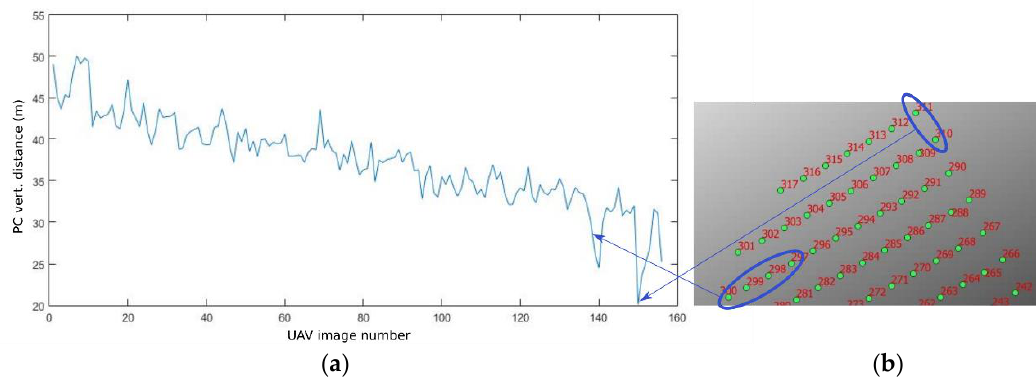
Figure 12. ( a ) UAV flight height above the plane DEM and ( b ) horizontal image-block. Labels are image filenames.